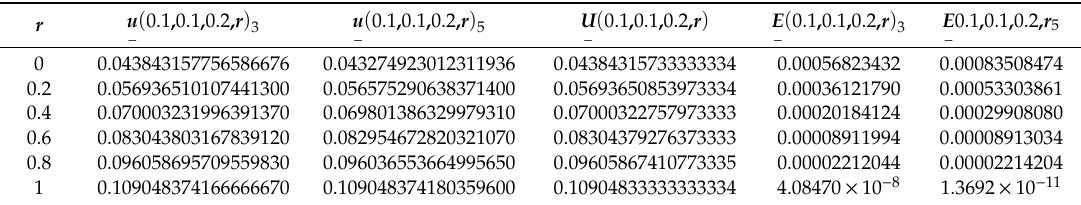
Table 2. Solution and accuracy of third and fifth order double parametric fuzzy HPM solutions for Equation (24) at t , x = 0.1 and b = 0.2 for all r ∈ [ 0,1 ] .